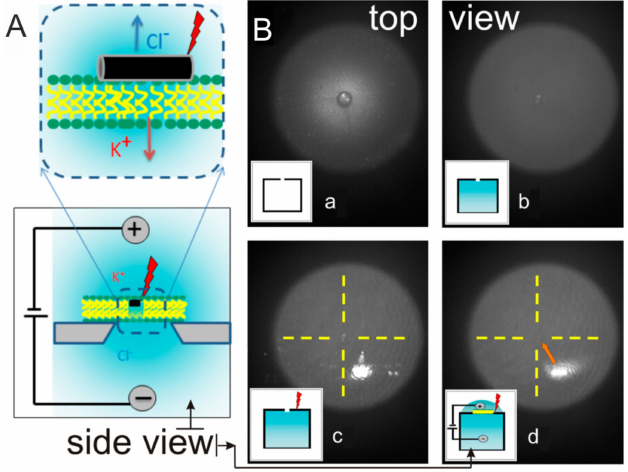
Figure 4. Scheme of the setup to perform the nanopore approach experiment for observation of traffic through lipid membranes. ( A ) Side view of the scheme of the experiment allowing observation and ( B ) images (top view) demonstrating the laser alignment on the glass chip [59]. Copyright 2014 American Chemical